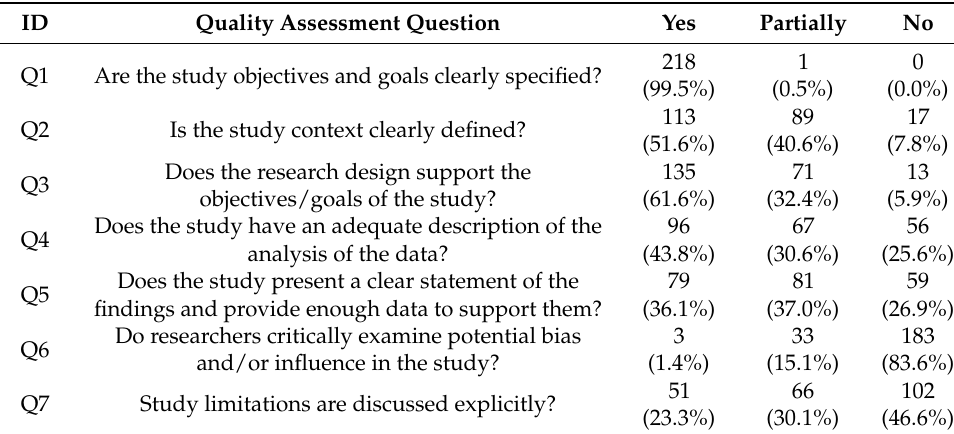
Table 6. Quality assessment